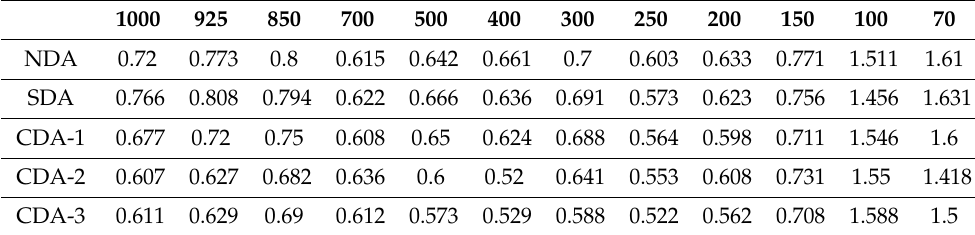
Table 4. The temperature RMSE (K) of 24 h forecasts verified against ERA-5 data at different levels (hPa).